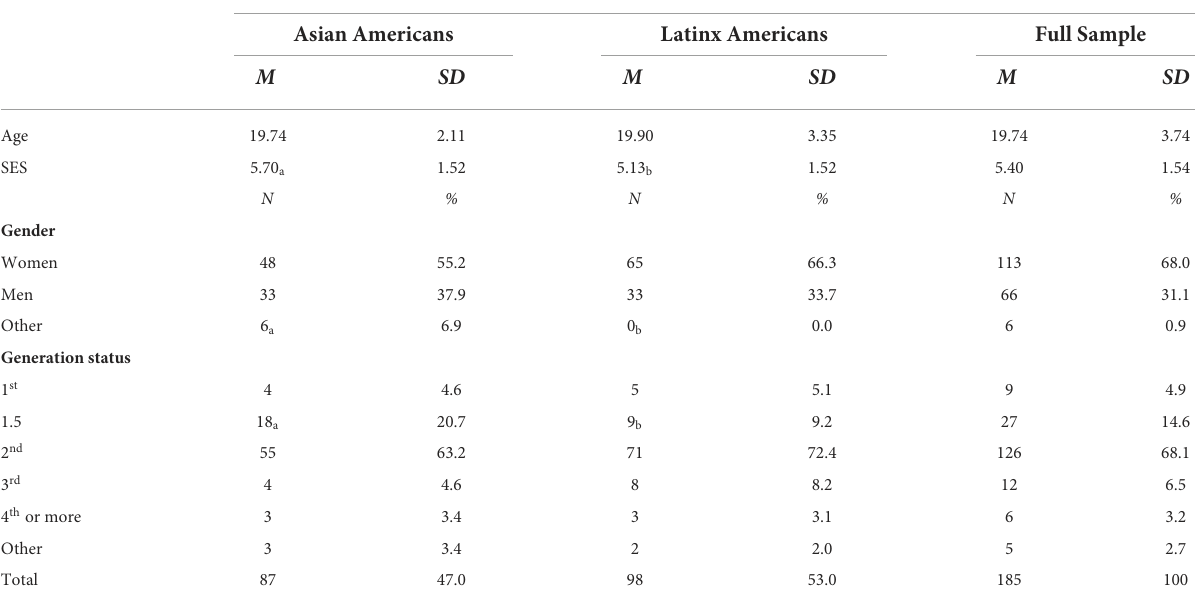
TABLE 5 Demographic characteristics and descriptives of study variables compared across asian and Latinx samples for study 2 (September 2021–April 2022).